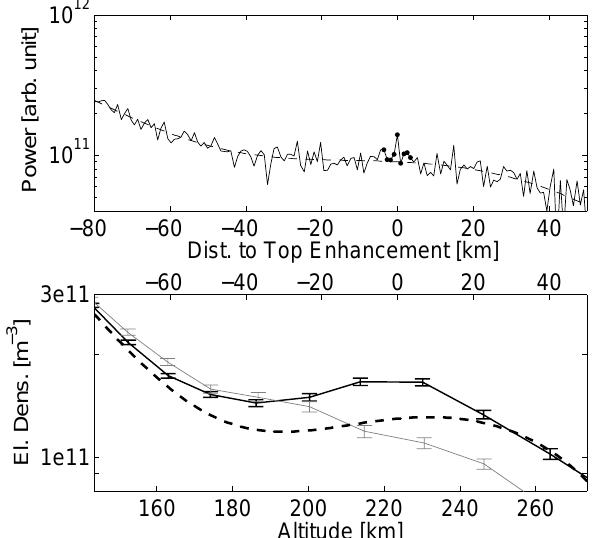
Fig. 5. The top panel shows the power profile with conditional inte- gration (described in the text) between 1700 and 1706 (solid line). A polynomial fit is shown as dashed line. The lower panel shows the power profile in the top panel, adjusted to account for the mea- sured electron-to-ion temperature ratio (dashed line). Electron den- sity profile obtained by ion line fitting (standard analysis) with time integration 1700–1706 (1652–1658) is shown as solid black (gray) line with error bars. The curves are aligned such that the distance to the top enhancement of the temperature corrected power profile is relative to an altitude of